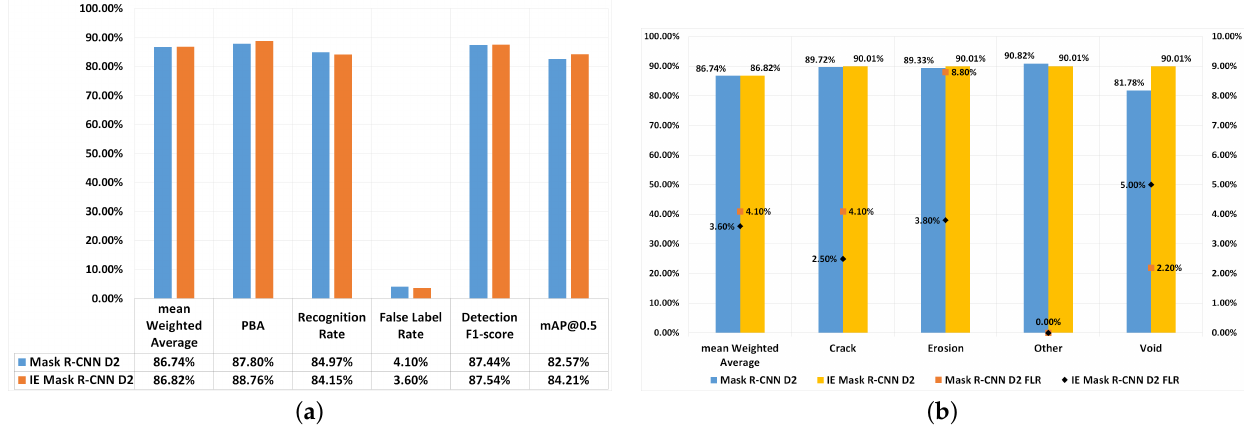
Figure 4. Performance comparison between Mask R-CNN(D2) and IE Mask R-CNN(D2). ( a ) Overall performance compar- isons. ( b ) mWA evaluation and FLR comparisons. Left axis is used for mWA, and the right axis is used for